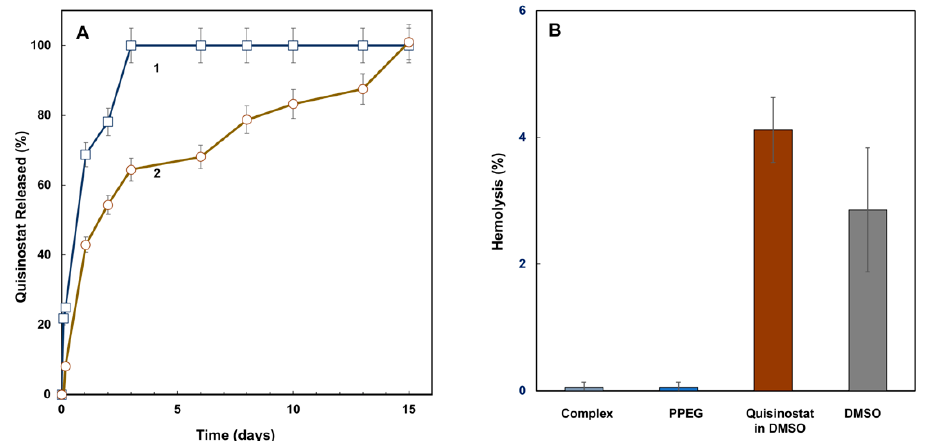
Figure 3. ( A ) Kinetics of quisinostat release from complex expressed as a percent of initial load of drug for samples with quisinostat to PPEG molar ratio in the complex of 5 (1) and 38 (2) (PBS, pH 7.4; Franz diffusion cell); ( B ) hemolytic activity of quisinostat-PPEG complex (activity for 38 drug-to-polymer molar ratio, other complexes are similar), PPEG solution of quisinostat in 10% ( v / v ) DMSO and 90% ( v / v ) PBS mixture (RBCs, 37 °C, 1 h, n = 3, mean values reported, error bars represent standard deviations).